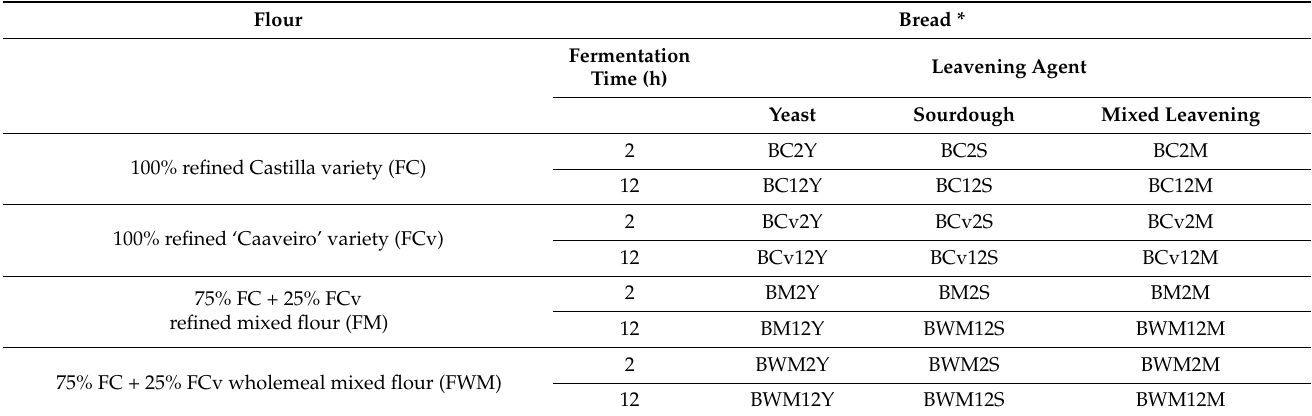
Table 1. Flour composition and characteristics of resulting